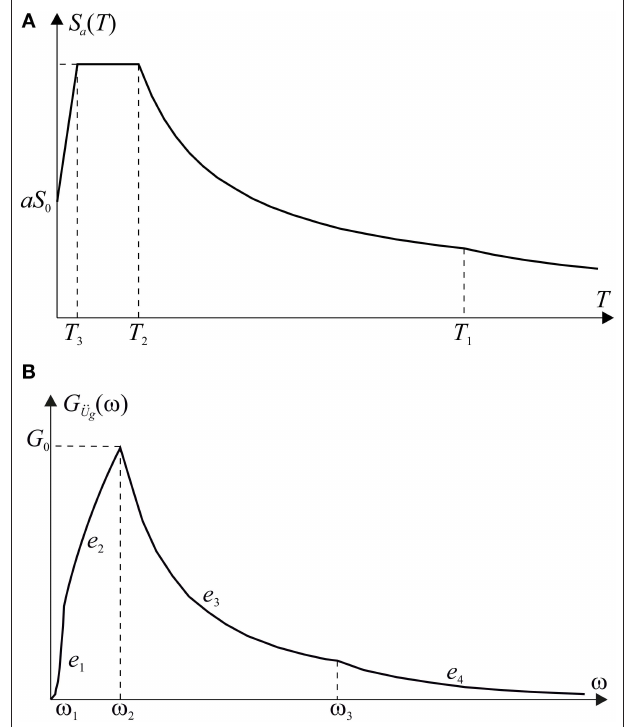
FIGURE A1 | (A) Pseudo-acceleration Response Spectrum; (B) Power Spectral Density function coherent with Response